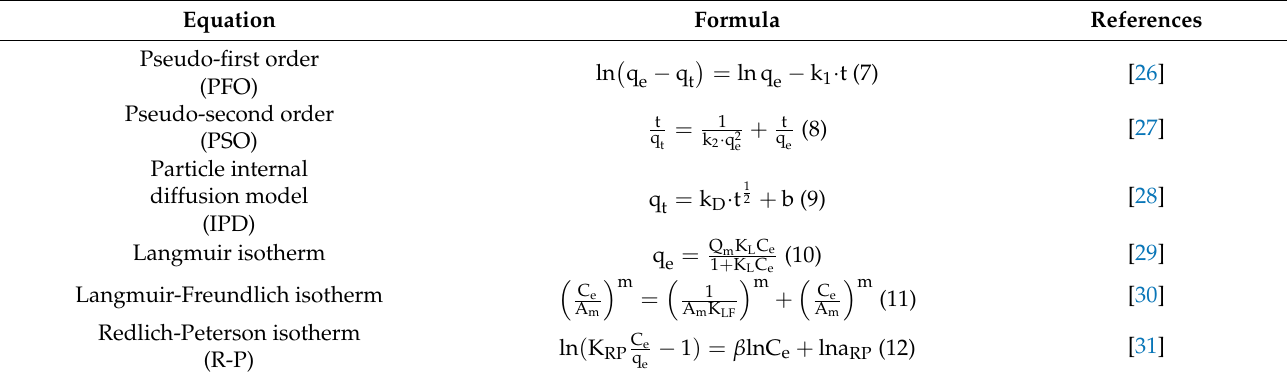
Table 1. Adsorption modelling equations.